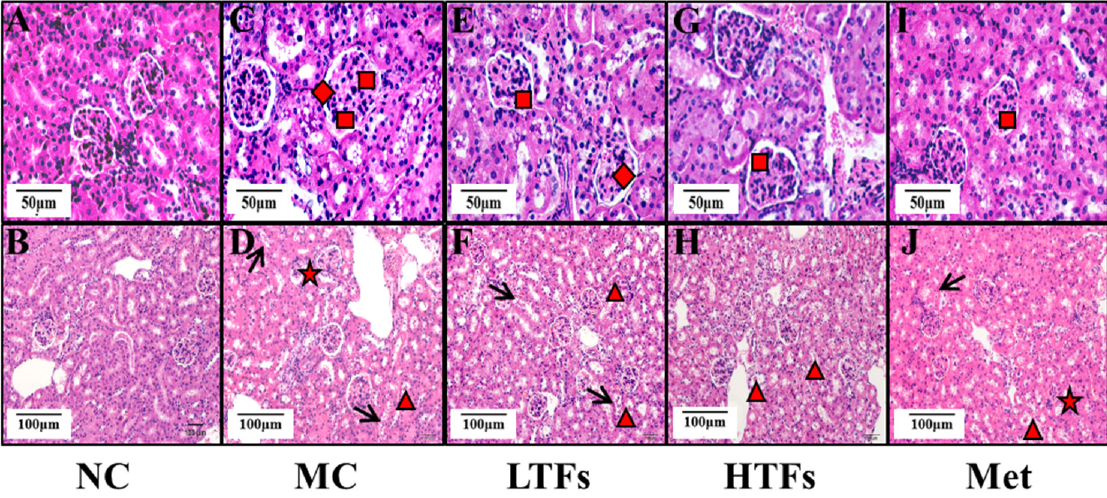
8 of 17 Figure 3. Effects of TFs on kidney function in T2DM mice. ( A ) 24 h urinary protein levels; ( B ) urinary